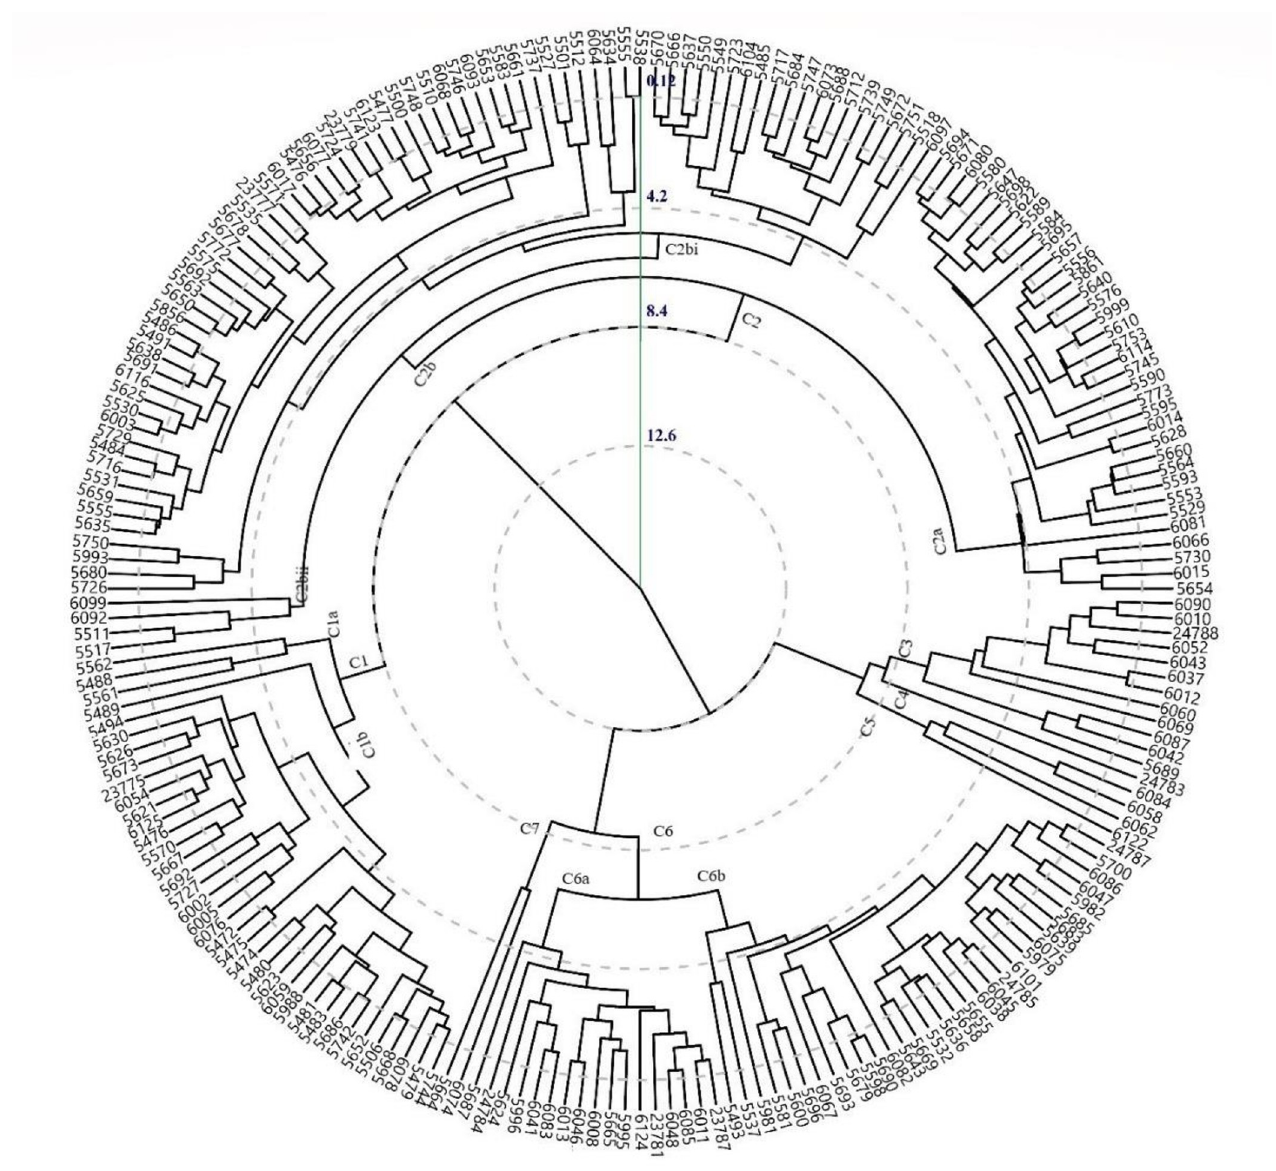
Fig 6. Hierarchical dendrogram showing the relationship of lentil genotypes for quantitative traits studied during 2018–19.